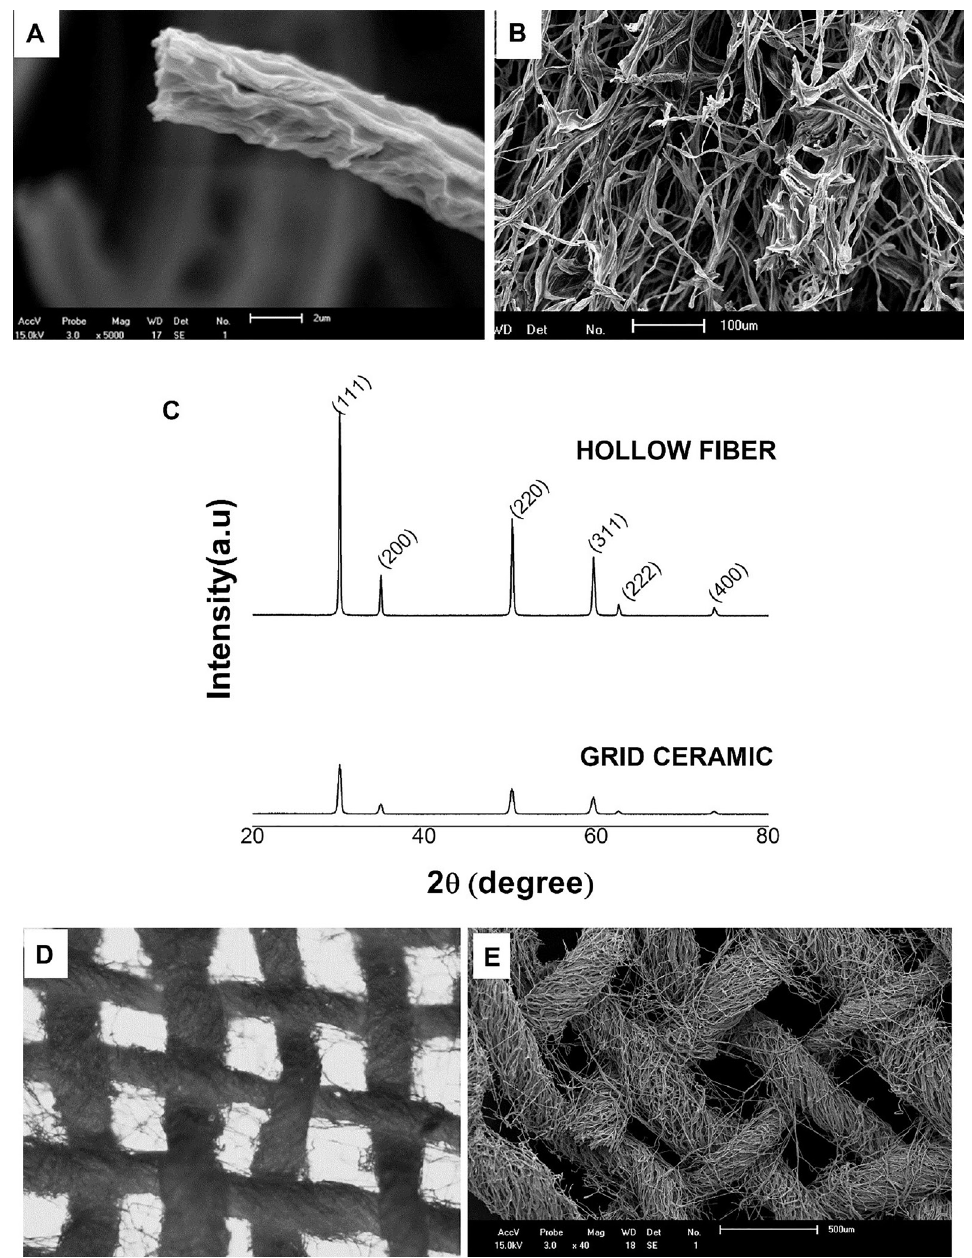
Figure 3. (A)(B)(C)(D) SEM micrograph images of ZrO 2-stabilised Yttrium oxide hollow fiber membranes at 800 °C for 3 h and (C) XRD pattern of cotton of ZrO 2-stabilised Yttrium oxide hollow fiber membranes. Table 1: Sample characterization by N 2 adsorption annealing at 1000 o C for 3h. Template anneling at 1000 o